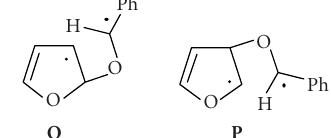
Figure 4: Possible biradical intermediates in the reaction of furan with benzaldehyde.